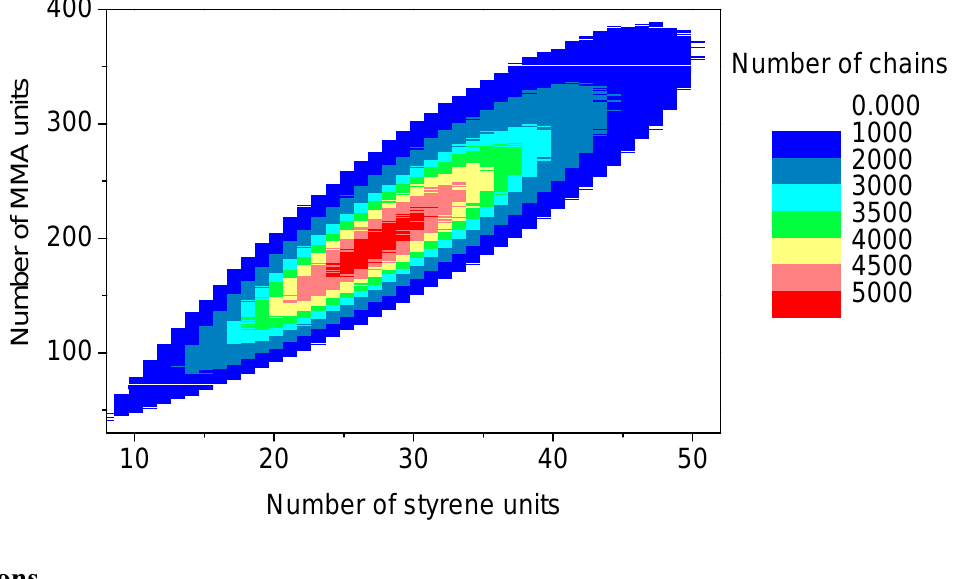
Figure 15. Contour plot: Coupling copolymer composition with chain length